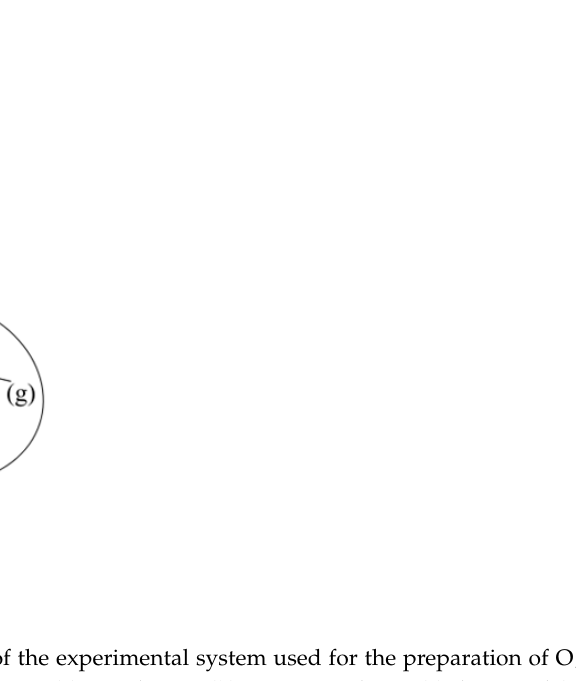
Figure 8. Schematic representation of the experimental system used for the preparation of O/W emulsion using porous glass membrane: ( a ) membrane; ( b ) compressed gas; ( c ) dispersed (oily) phase reservoir; ( d ) emulsion reservoir and continuous phase (aqueous phase); ( e ) and—magnetic stirrer; ( f ) dispersed phase; ( g ) continuous phase.